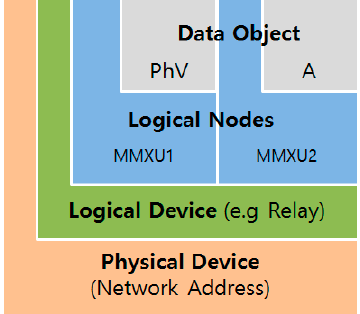
Figure 2. IEC 61850 information model.